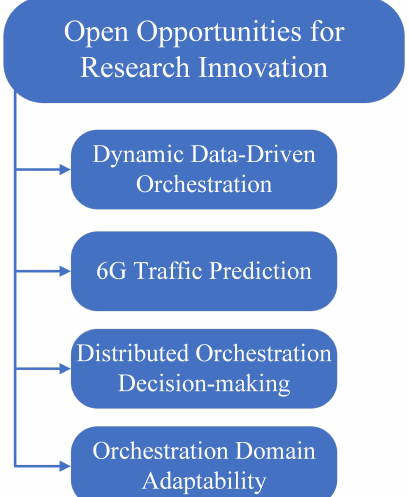
Figure 5. Research opportunities for innovation for intelligent